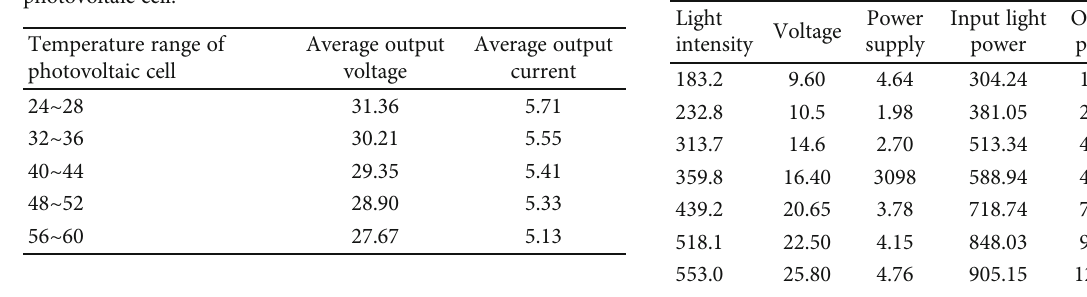
Table 4: Temperature, output voltage, and current of the photovoltaic cell.